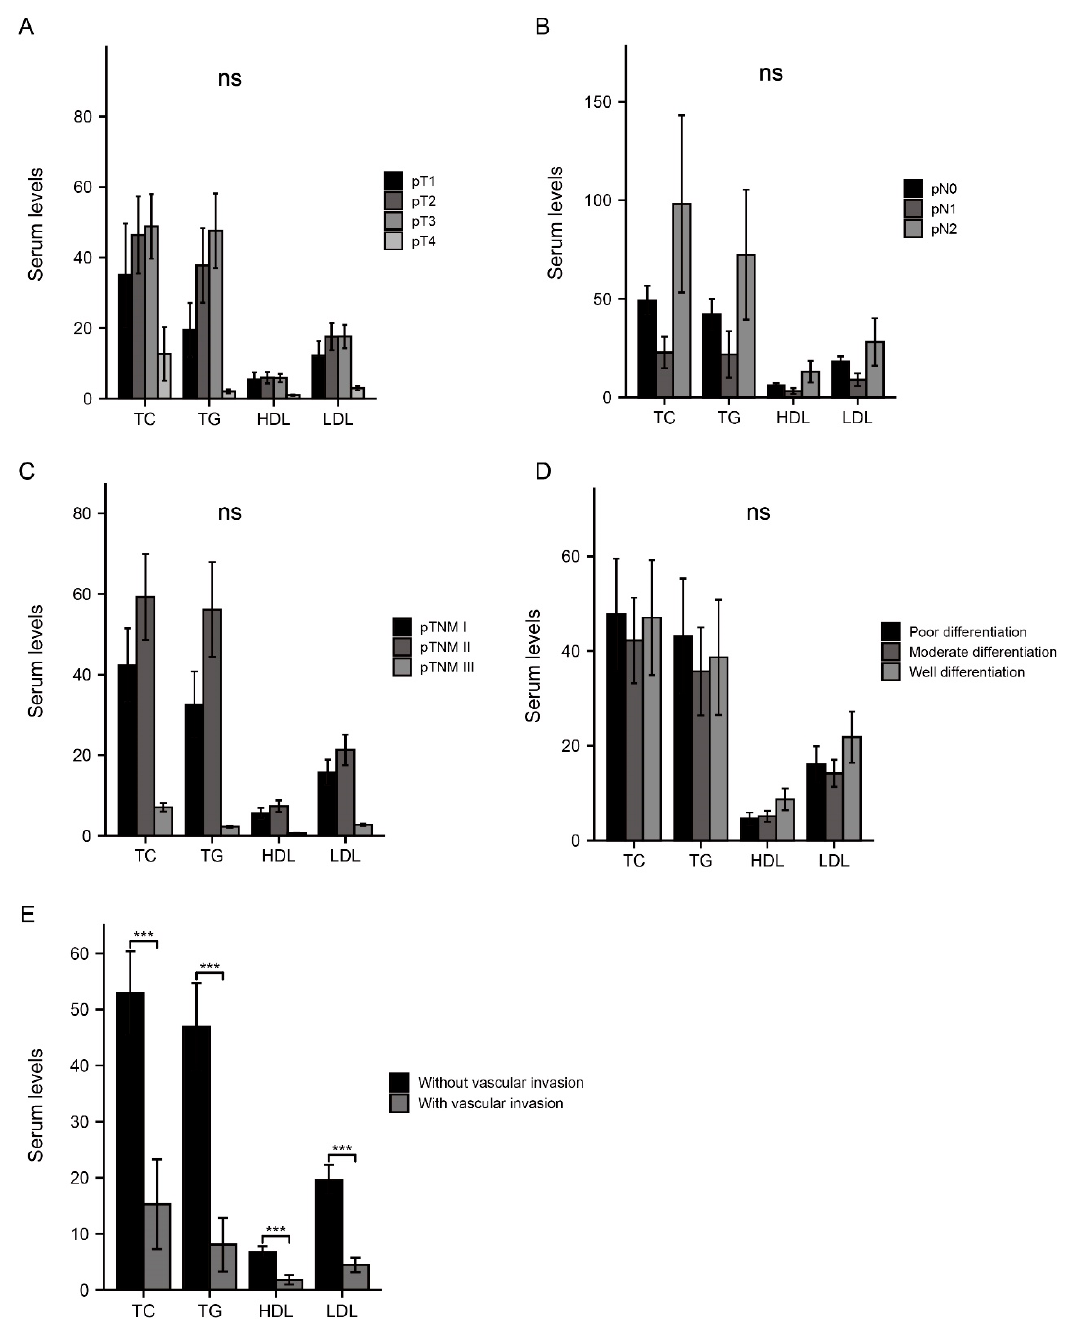
Figure 1. Correlation analysis between serum lipids and invasive factors. The serum levels of TC, TG, HDL, and LDL in different groups divided by pT ( A ), pN ( B ), pTNM ( C ), differentiation status ( D ), and vascular invasion status ( E ). ***, p < 0.001; ns, no significance.